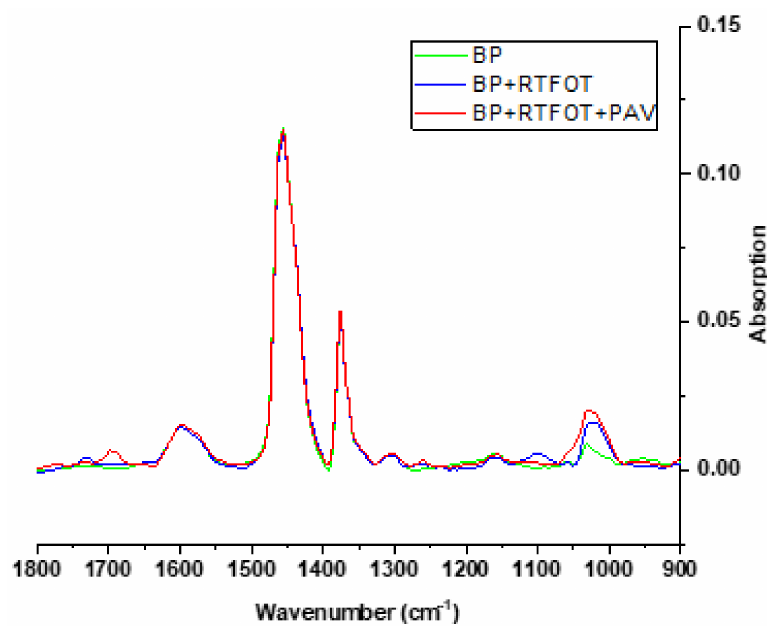
Figure 9. FTIR spectra for BP at all ageing stages.